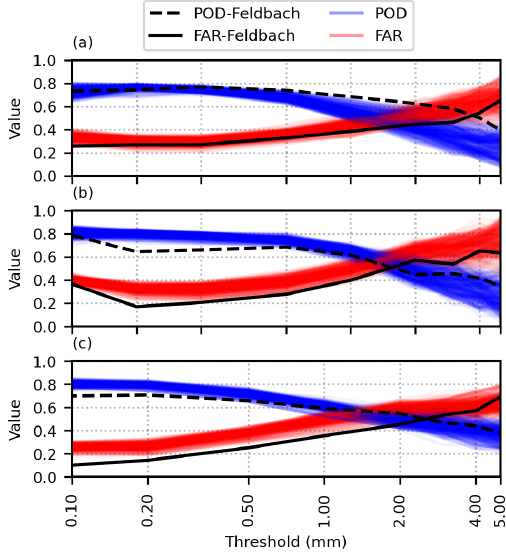
Figure 5. POD and FAR values based on different thresholds for each cell for 2007–2011 (a) , 2012–2014 (b) , and 2015–2018 (c) . Note that the dashed black and black lines indicate POD and FAR for the Feldbach cell,